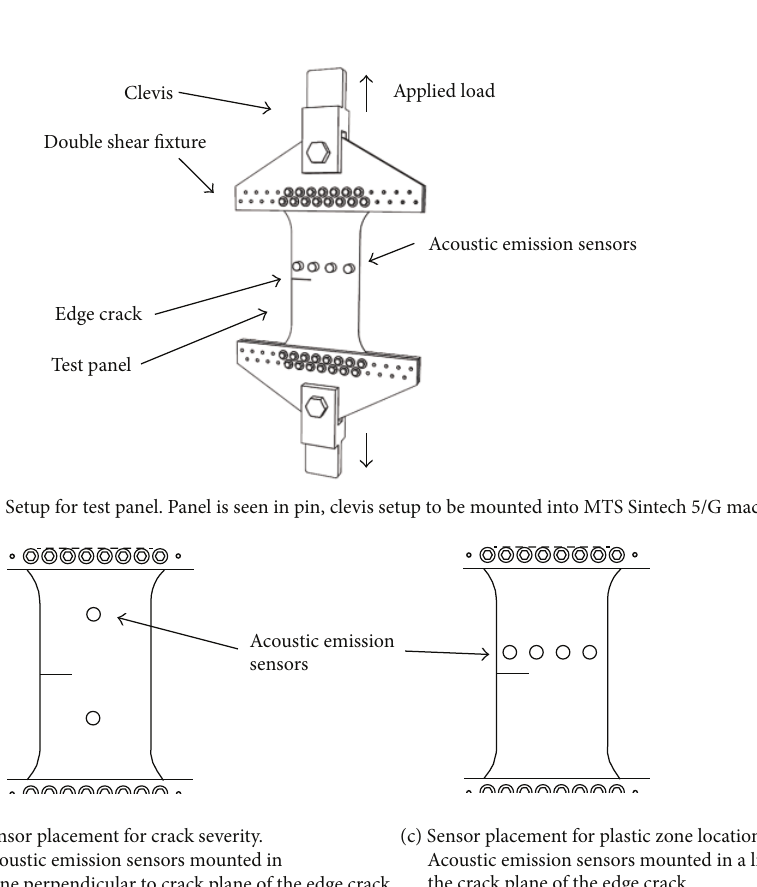
Figure 6: Dimensions of test panels used for experiment. Panels consisted of Al 2024-T3.